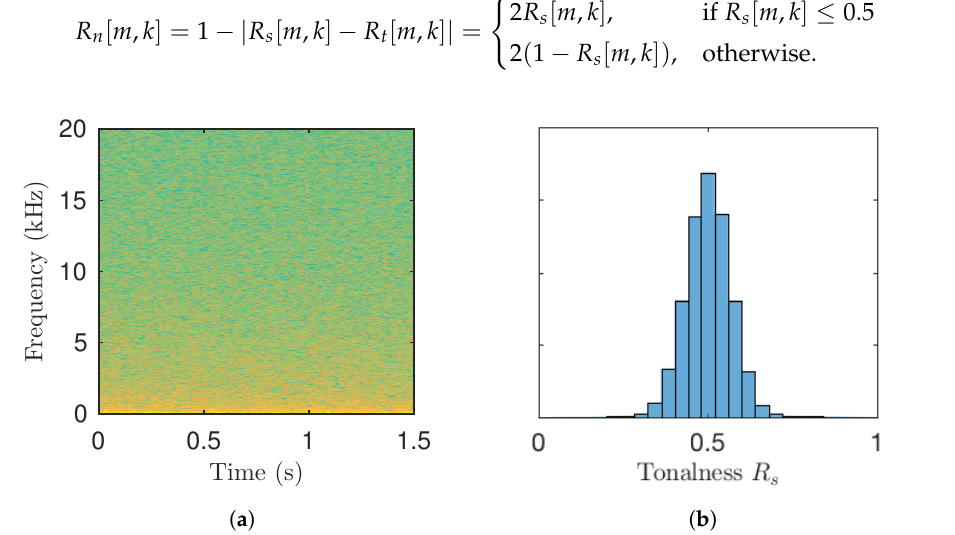
Figure 2. ( a ) Spectrogram of pink noise and ( b ) the histogram of tonalness values for its spectrogram bins.